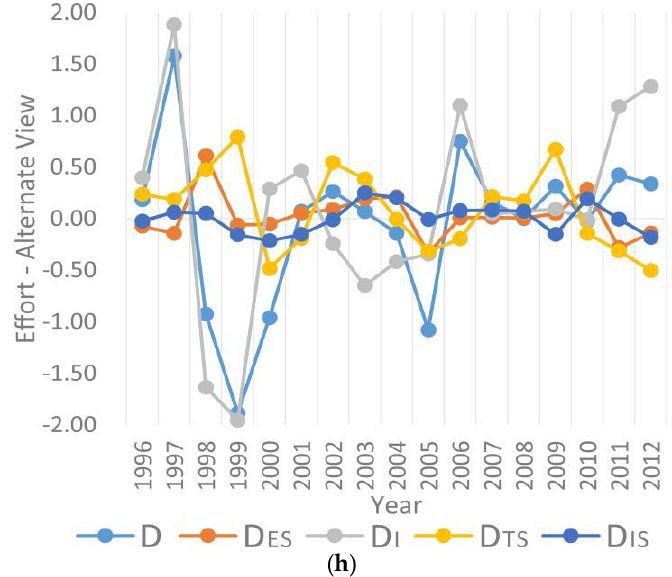
Figure 8. The variation which reflected the five-year periodic pattern: ( a ) The growth of GDP, GDPPC, TO and SO; ( b ) Proportions of the transport sector in tertiary industry, weighted by output (TS) and energy intensity; ( c ) Growth of transport energy consumption and TCE; ( d ) Transport energy intensity and average TCE coefficient; ( e ) Decoupling index in initial view; ( f ) Decoupling index in alternate view; ( g ) Decoupling effort in initial view; ( h ) Decoupling effort in alternate view. Table 3. The periodic variation of the factors’ value in each plan.